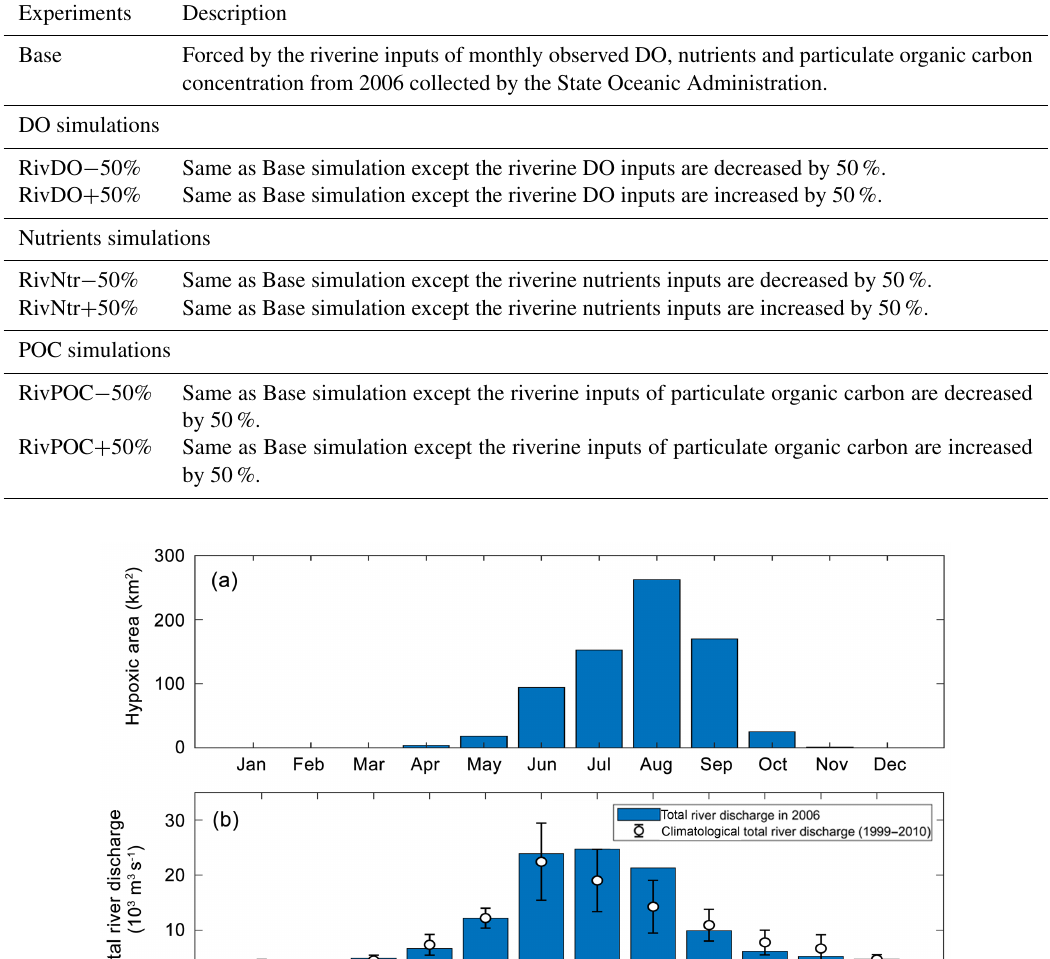
Table 1. Overview of model experiments.